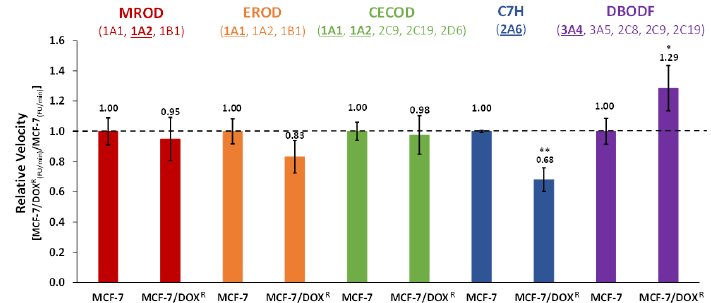
Figure 2. Normalized relative velocities of the CYP activity assays in MCF-7/DOX R 25 nM microso- mal fractions. Values are represented as mean ± SD of technical replicates (N = 3) (* p < 0.05; ** p < 0.005). MROD (red) and EROD (orange) mediated mainly by CYP1A1 (particularly EROD), 1A2 (particularly MROD), and to a minor extent by 1B1; CECOD (green) mediated particularly by CYP1A1, 1A2, and to a minor extent by 2C9, 2C19, and 2D6; C7H (blue) mediated by CYP2A6; DBFOD (purple) mediated mainly by CYP3A4, and to a minor extent by 3A5, 2C8, 2C9, and 2C19. CYP isoenzymes particularly relevant in the specific activities studied are underlined.